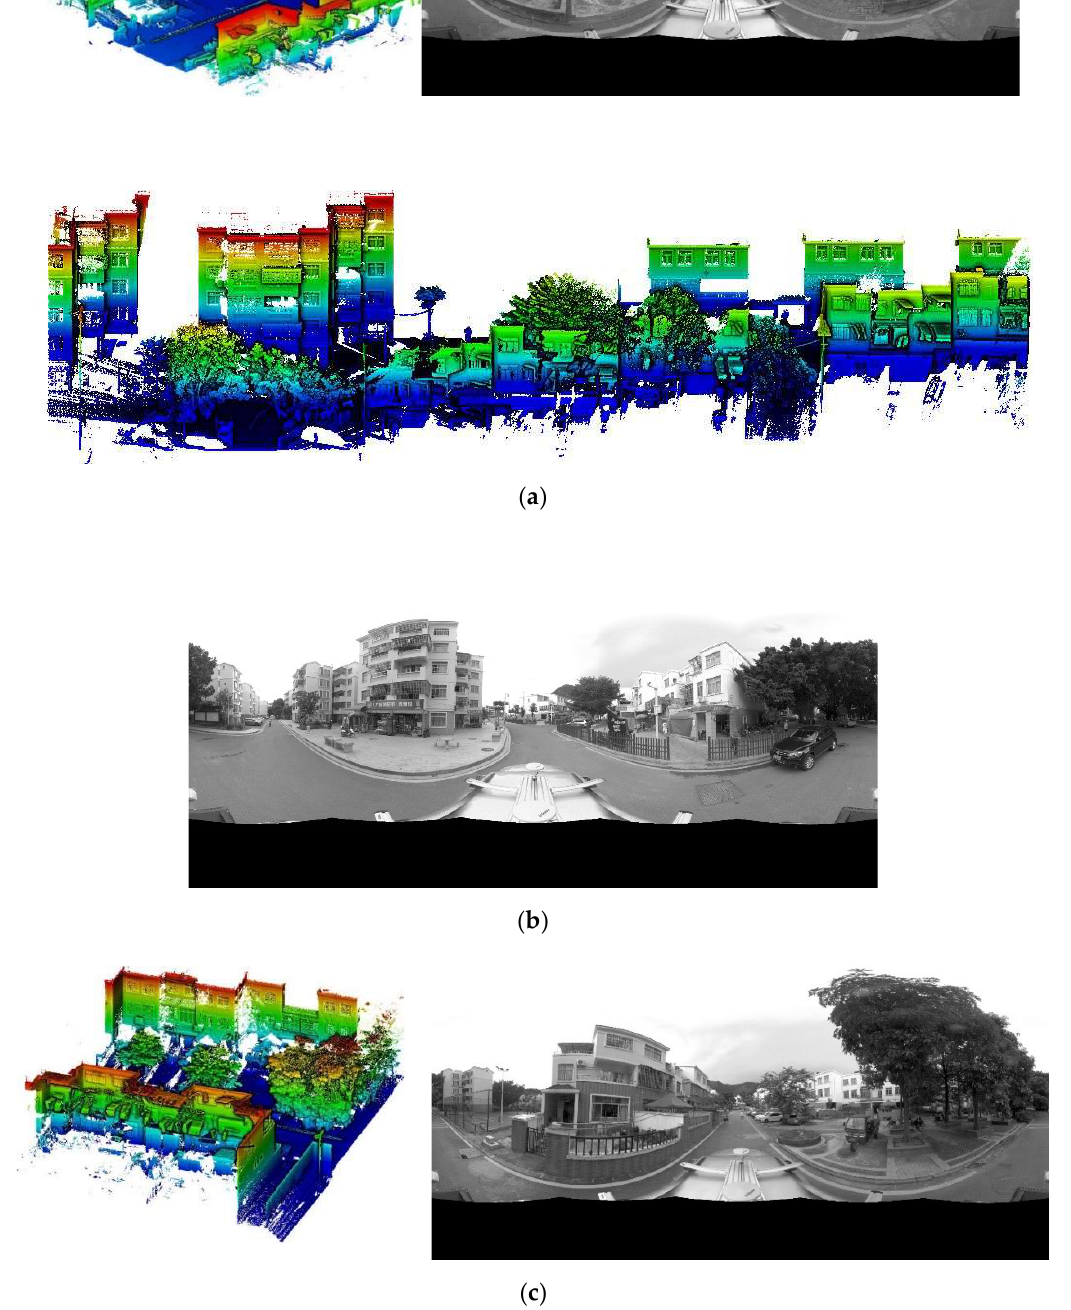
Figure 7. Experimental data: ( a ) Mobile LiDAR data and panoramic image of test 1; ( b ) Mobile LiDAR data and panoramic image of test 2; ( c ) Mobile LiDAR data and panoramic image of test 3.